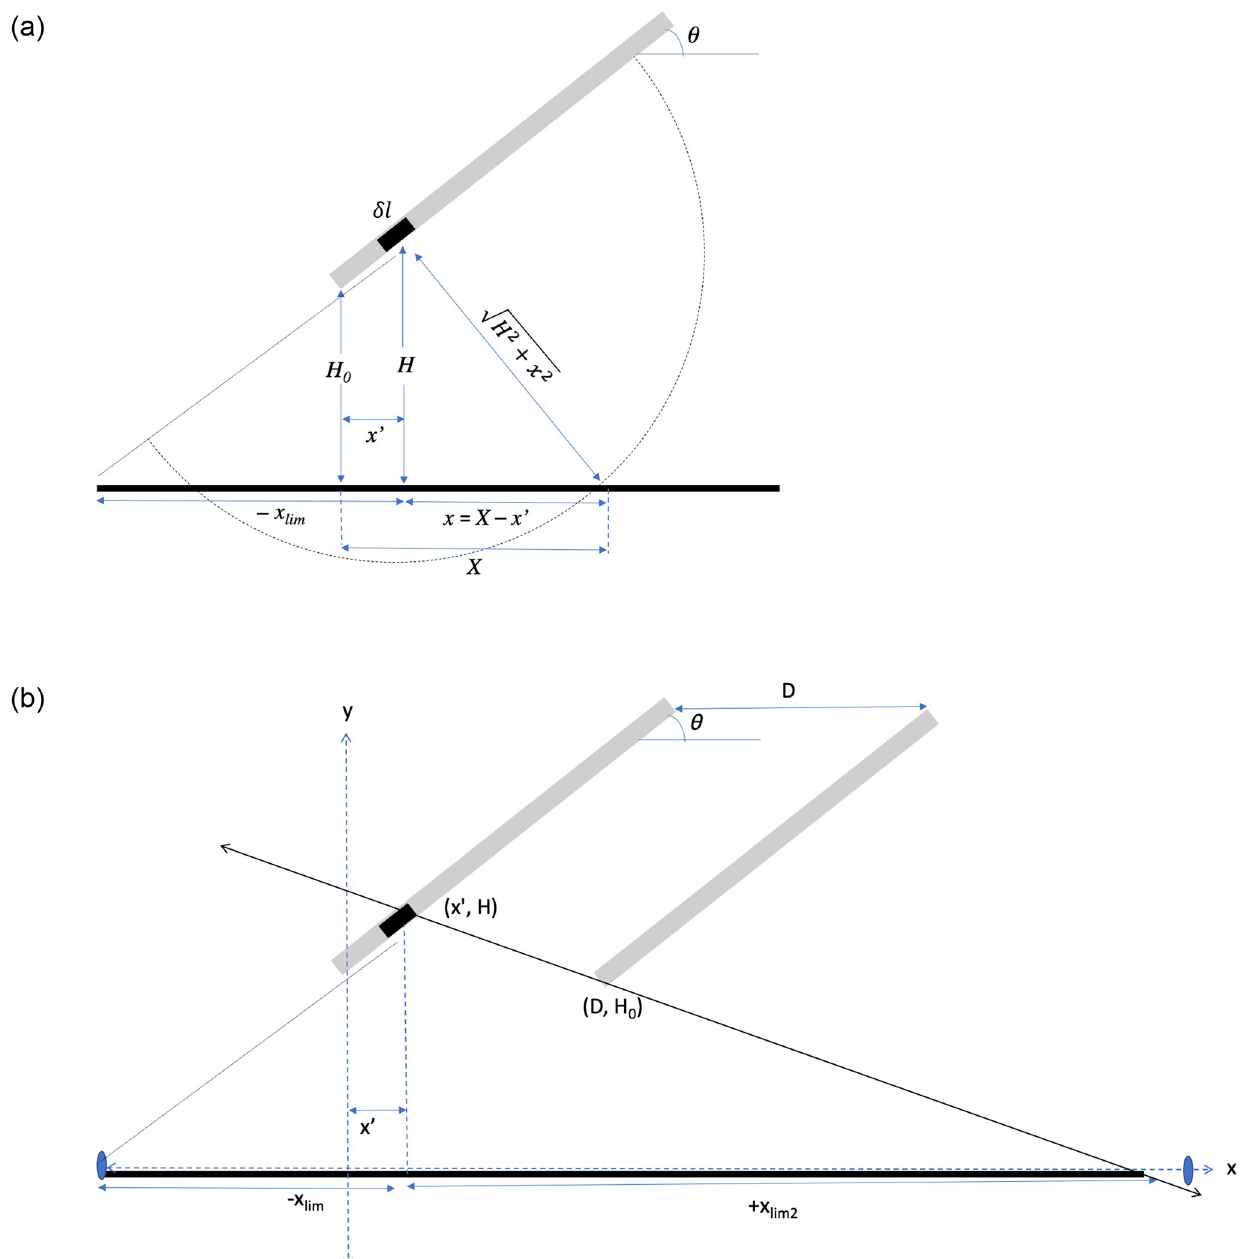
Fig 2. a. Heat flux from a differential panel element. b. Limits of influence for a given panel element (Not to scale with case study array). Note that x’ is a constant because it represents a single panel element, but X is an array of ground positions across the entire solar array that will each have unique flux values. The result is an array of values for q at each X . The range of X is bound. For X < 0, the range extends to e , which is the point on the ground if one were to extend the panel to touch the ground (See x lim on Fig 2a, 2b). For X < − x , the radiation is blocked by the lower panel elements. x lim lim